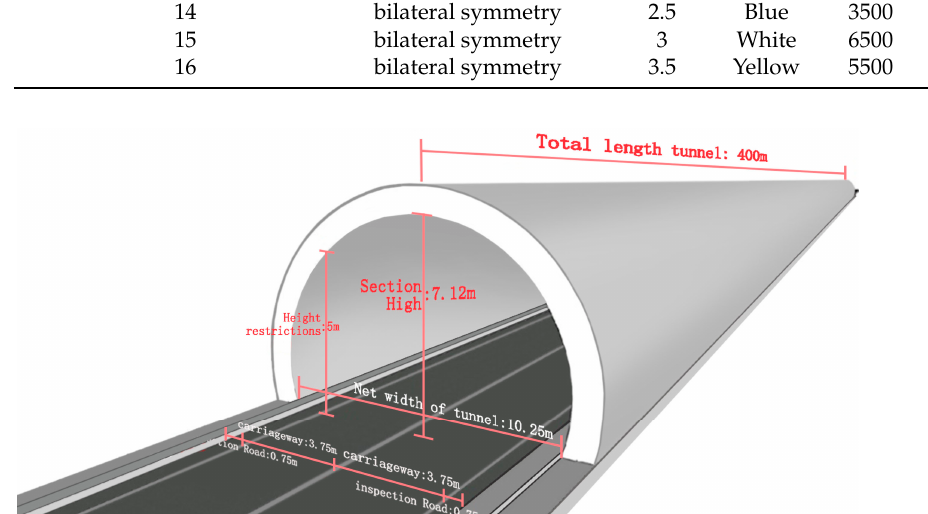
Table 4. Entrance section and exit section tunnel lighting settings.